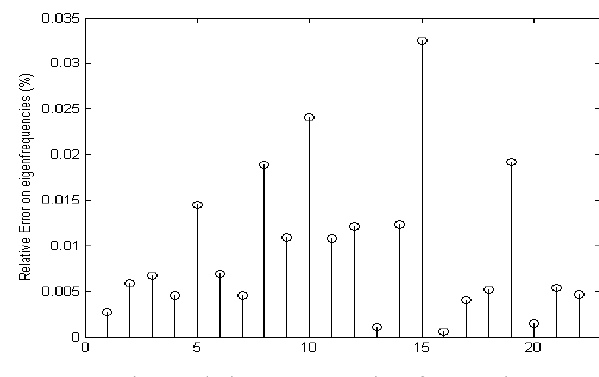
Fig.5 Relative errors on